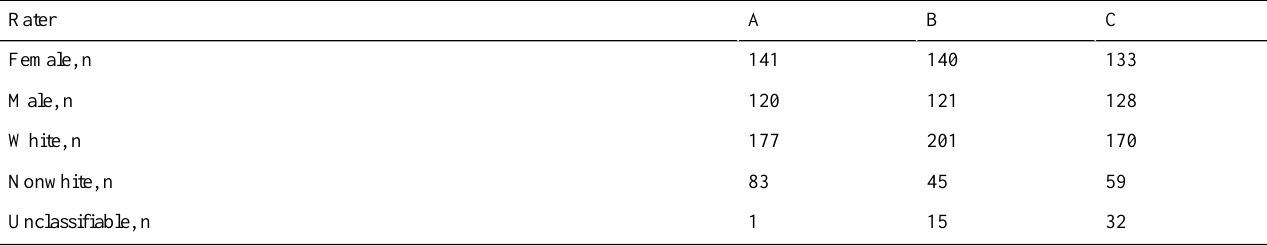
Table 2. Data summary by rater for #health